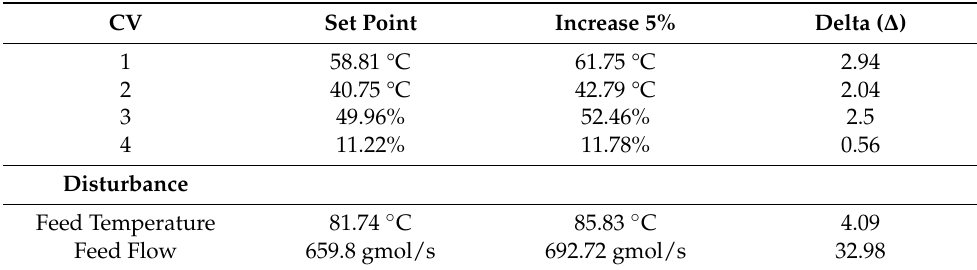
Table 9. Final value of Simulink’s step